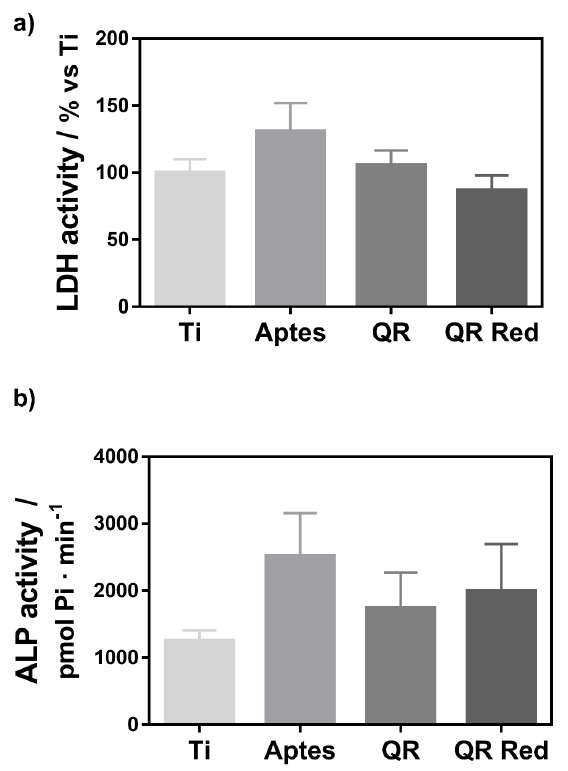
Figure 5. ( a ) LDH (lactate dehydrogenase) activity and ( b ) ALP (Alkaline phosphatase) activity measured in the wound fluid that was collected from the implant site after removing the implant. Values represent mean ± SEM, n = 6. No statistical differences were found between the groups. Figure 6 shows the gene expression analysis from peri-implant bone tissue for bone resorption ( Trap , CalcR , Ctsk , H + Atpase , Mmp9 ), inflammation ( Il-10 , Tnf-α ) and osteoblast-osteoclast interaction ( Opg and RankL ) markers. Regarding inflammation markers, no significant differences were found between the groups. There were no significant differences in the expression levels of phenotypic osteoclastic markers, however the expression of the functional osteoclastic markers Ctsk , H + Atpase and Mmp9 was significantly lower for quercitrin implant surfaces. Finally, although no differences